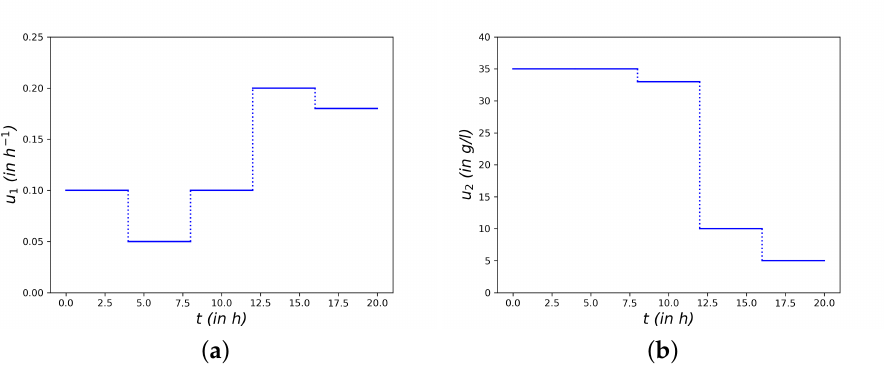
Figure 9. Example of the parameterized input functions ( a ) u 1 ( t ) and ( b ) u 2 ( t ) for the yeast fermen- tation